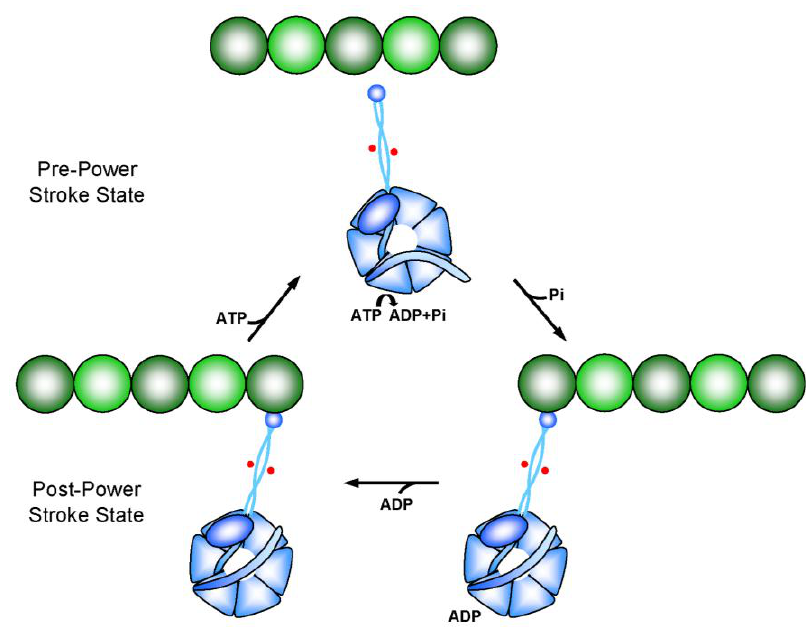
FIGURE 3. The transitions between the pre- and postpower stroke states are dependent on transient, cyclical, and highly coordinated interactions between the structural elements of the dynein head. Upon binding of ATP (for simplicity only ATP binding to AAA1 is shown), the stalk  α-helical coiled coil undergoes a conformational shift (indicated by the red dots) that releases the dynein head from the microtubule and accelerates hydrolysis of ATP to ADP and Pi. The linker adopts its prepower stroke conformation by docking onto AAA2. Following release of Pi, the stalk resumes its high-affinity conformation that locks the dynein head onto the microtubule. The swing of the linker from its prepower stroke position at AAA2 to AAA4 triggers the power stroke and ADP is